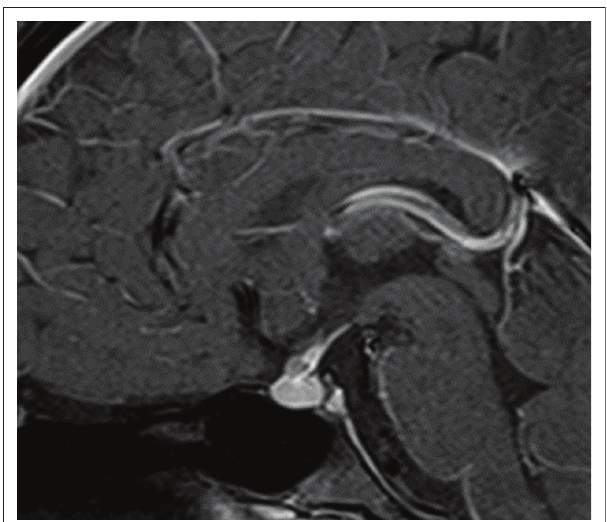
FIGURE 3: Contrast-enhanced MRI performed at an interval of 4 months after initiation of medical treatment with Cabergoline revealed no significant regression in the size of adenoma, despite the prolactin levels having returned to normal. The decrease in hormone levels usually precedes the reduction in tumour